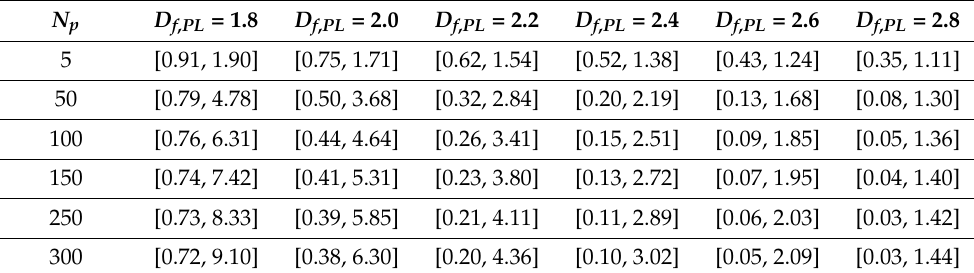
Table 4. Upper limit and lower limit of effective range of k PL from the simplified estimation without aggregate generation.